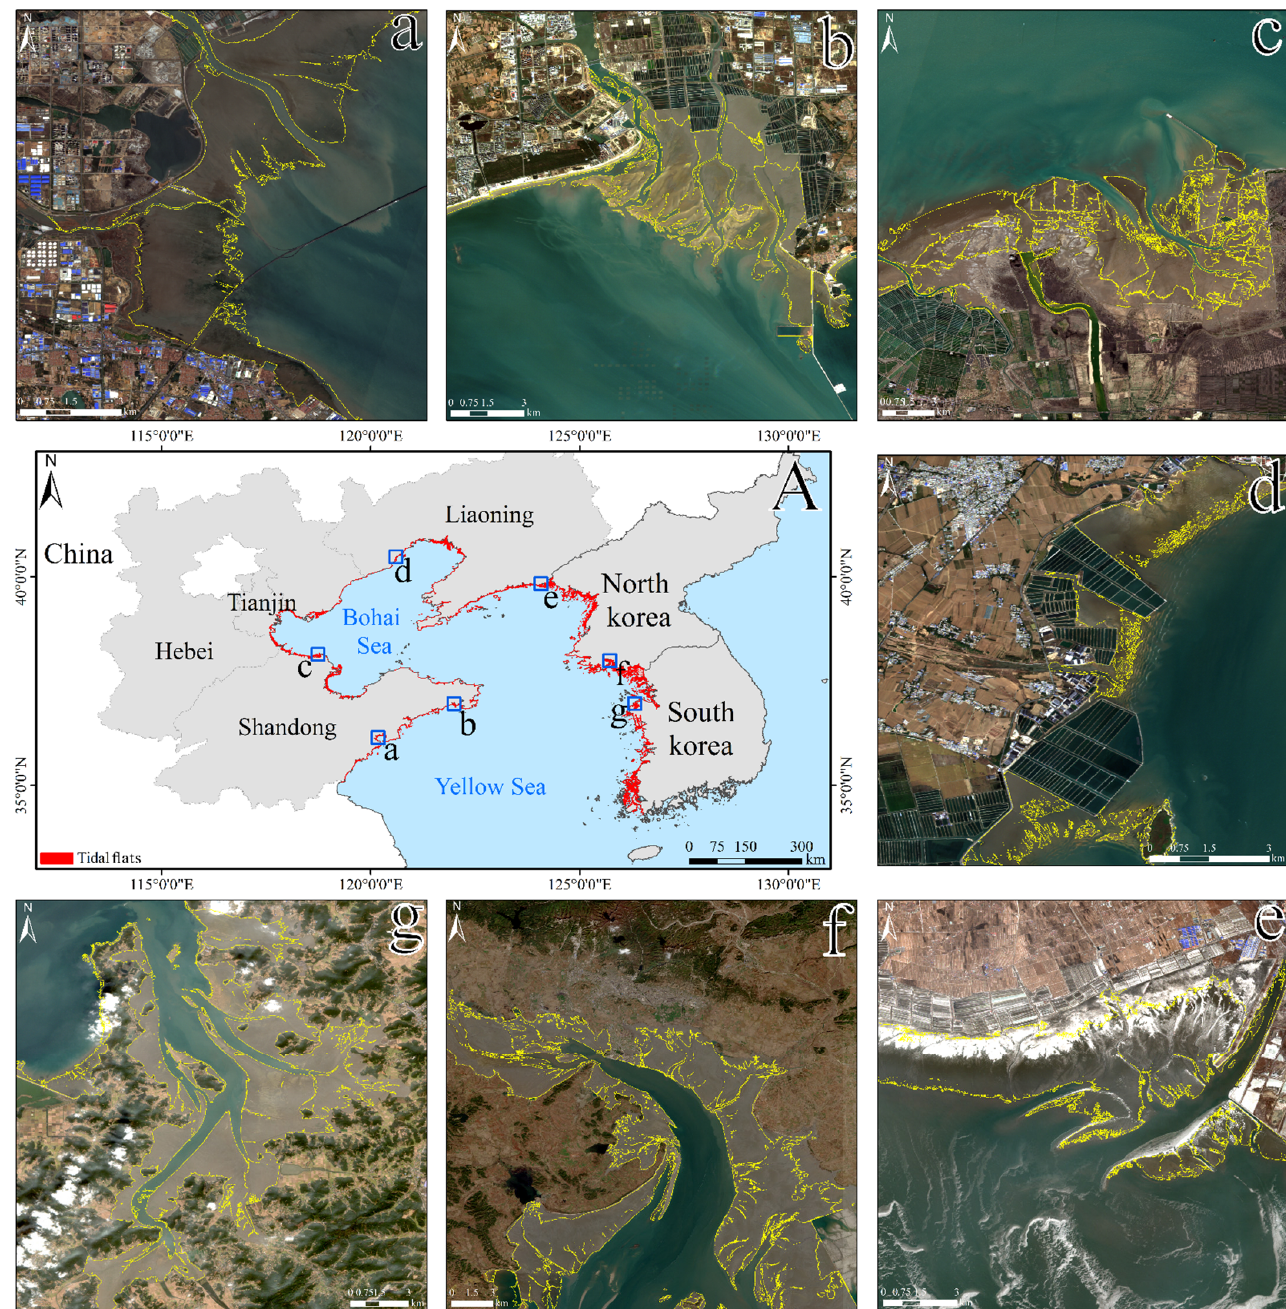
Figure 6. Spatial distribution and areal extent of tidal flats around the coast of the Bohai and Yellow Seas (A). ( a ) Tidal flats in Jiaozhou bay, ( b ) tidal flats in Wuleidao bay; ( c ) tidal flats in Diaokou; ( d ) tidal flats in the Yantai River estuary; ( e ) tidal flats around Dandong port; ( f ) tidal flats in Haeju bay; and ( g ) tidal flats around Ho-ri, Korea. The yellow line in sub-figure a–g delineates the extent of tidal flats proposed by our method. Optical base maps used in sub-figure a–g are the true color Sentinel-2 images during the lowest tide, which were acquired at 02:58 on 21 Apr 2020, 02:48 on 20 Oct 2020, 03:07 on 14 Apr 2021, 02:57 on 18 Oct 2020, 02:47 on 7 Feb 2021, 02:37 on 17 Oct 2020, and 02:28 on 19 Oct 2020, respectively.